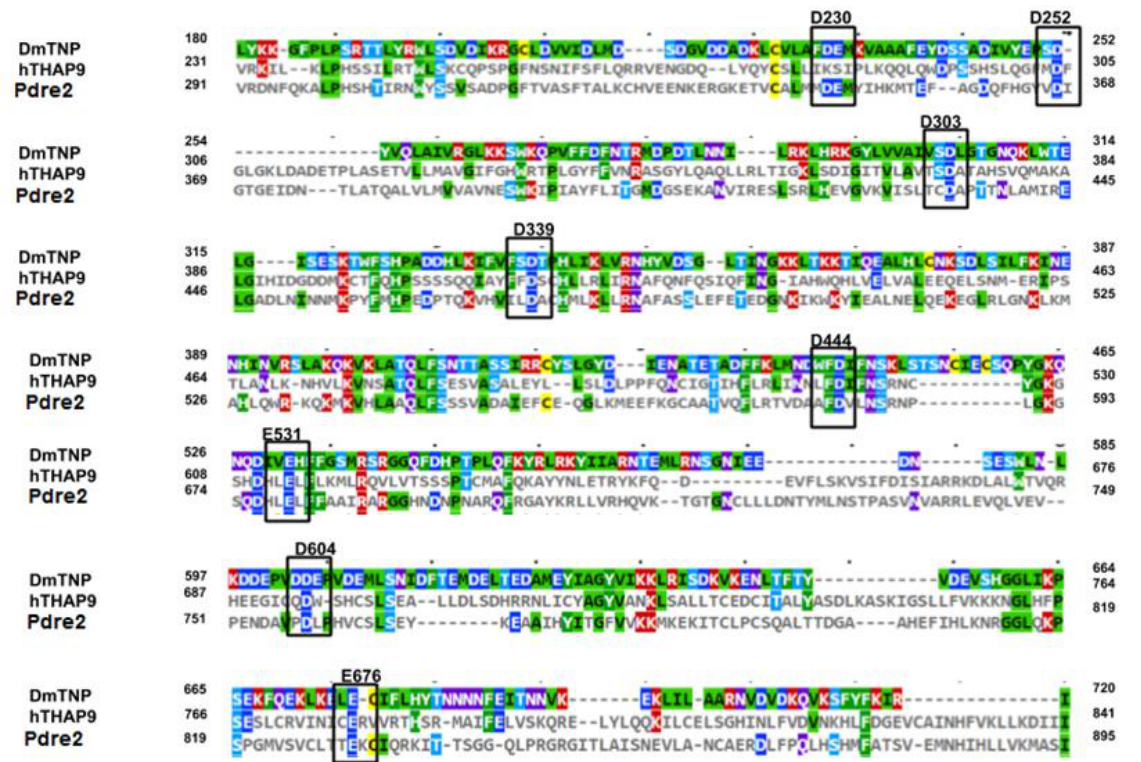
Figure 3. Sequence conservation in the putative RNaseH-domains of DmTNP, hTHAP9 and Pdre2. Amino acid sequences of DmTNP, hTHAP9 and Pdre2 were aligned using Clustal Omega and were visualized using MView. The Ds and Es that were conserved in the putative RNaseH-domains of all three homologs are highlighted in black boxes and labeled (in bold on top of the sequence) with the corresponding DmTNP residue number. The coloring scheme of the alignment is based on conserved physicochemical properties of amino acids (Colored by identity-Palette P1 of MView, refer to Figure S3 for the key).